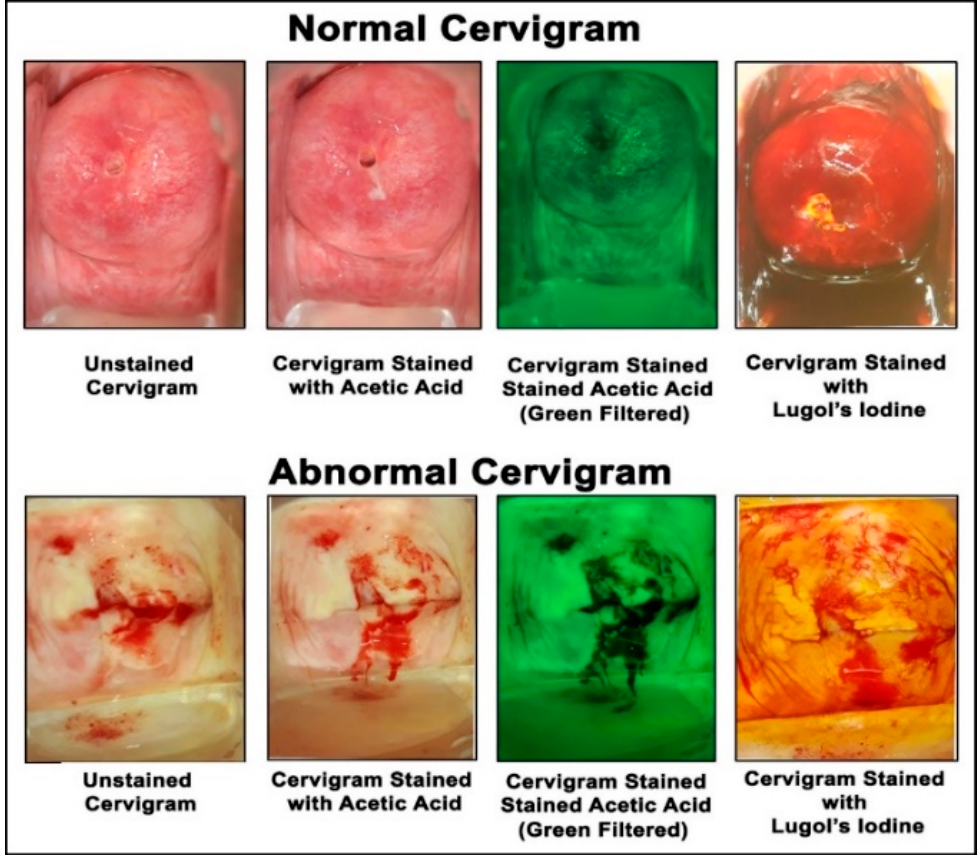
Figure 5. It shows the cervigrams stained with acetic acid (VIA) and Lugol’s iodine VILI to ascertain that the lesions stained with VIA are indeed cancerous, as exemplified by dysplasia Lugol’s iodine stain. The Lugol’s iodine stain works on the principle that the normal epithelial cells contain glycogen while the dysplastic and invasive cancer cells contain little or no glycogen. This is thought to be due to the Warburg effect of increased cytosol glycolysis consequent to the genomic chaos seen in the cancer cell. Iodine is glycophilic and forms tri-iodide molecules within the glycogen polymer spiral. This results in mahogany brown staining of normal epithelial cells. Areas of dysplasia and invasive cancer do not take up iodine as they lack glycogen and appear as pale mustard-colored areas. Modules of health literacy about adoptive sexual and reproductive health practices will also be integrated into the software solution to alleviate the burden of this disease in vulnerable populations belonging to the lowest socioeconomic strata.